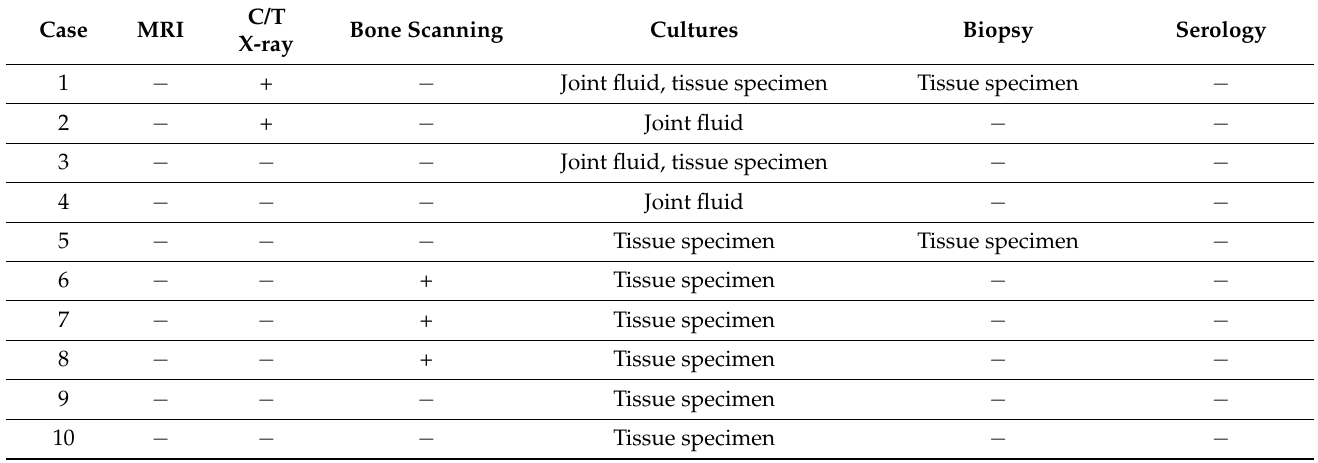
Table 2. Definite diagnosis of periprosthetic joint infections caused by fungus and imaging techniques that each case underwent during the process of diagnosing the infection. MRI: magnetic resonance imaging, CT: computer tomography, ( − ): not mentioned in the original cases, (+): performed in the original